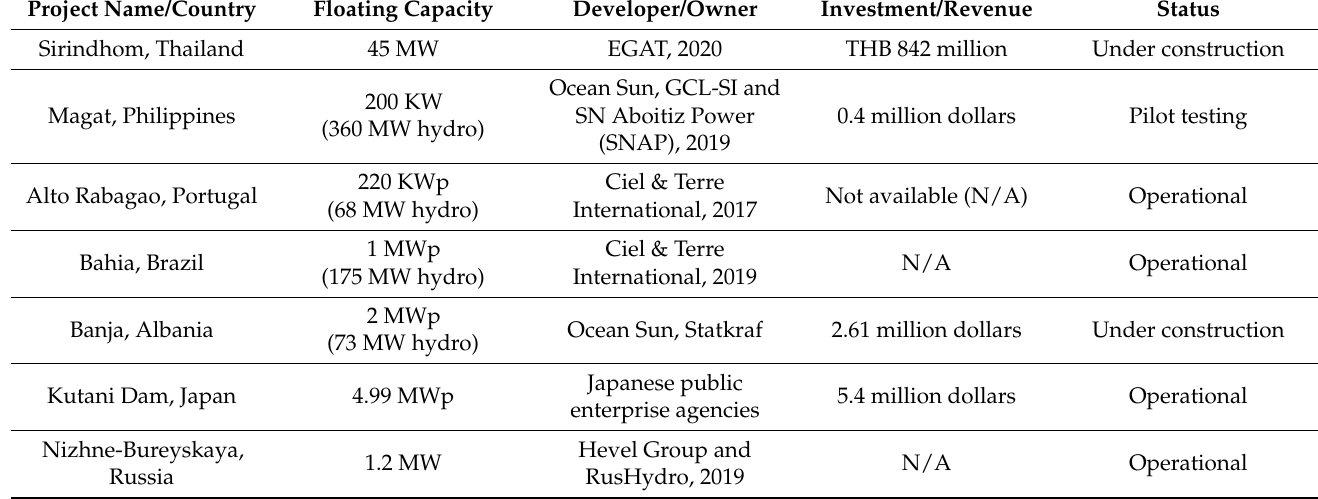
Table 2. Status of hybrid FPV plant worldwide (not exhaustive).